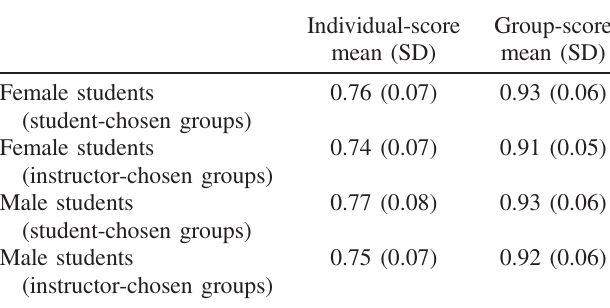
Table of mean (standard deviation) individual-exam scores and group-exam scores broken down by gender and group type (student-chosen versus instructor-chosen